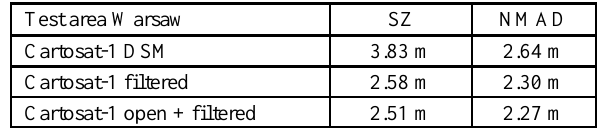
Table 5: accuracy analysis of a Cartosat-1 height model